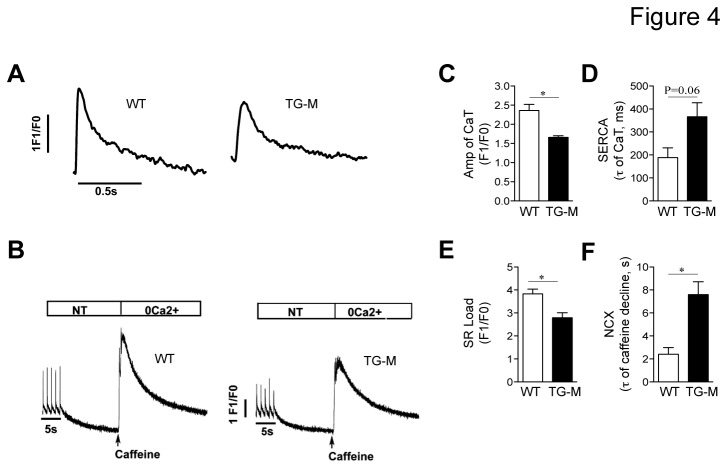
Diminished sarcoplasmic reticulum (SR) Ca2+ load and Ca2+ transient in miR-22 transgenic mice.(A) Representative traces of Ca2+ transients from TG-M and WT adult ventricular cardiomyocytes upon 1Hz pacing in 1.8mmol/L, Ca2+ Tyrode solution, and (B) after rapid exposure to 10mM caffeine. Note that the sweep velocity was constant and the time scale was identical to data in first panel. (C) Quantification of electrically evoked Ca2+ transients, and (E) estimation of SERCA2 activity from time constant of Ca2+ transient decline (τ of CaT) in TG-M and WT myocytes. (D) SR Ca2+ load response, and (F) NCX activity estimation during caffeine stimulation (τ of caffeine decline) in 0 Na+, 0 Ca2+ Tyrode solution (n = 3-4 mice). Student t test. *, P<0.05.